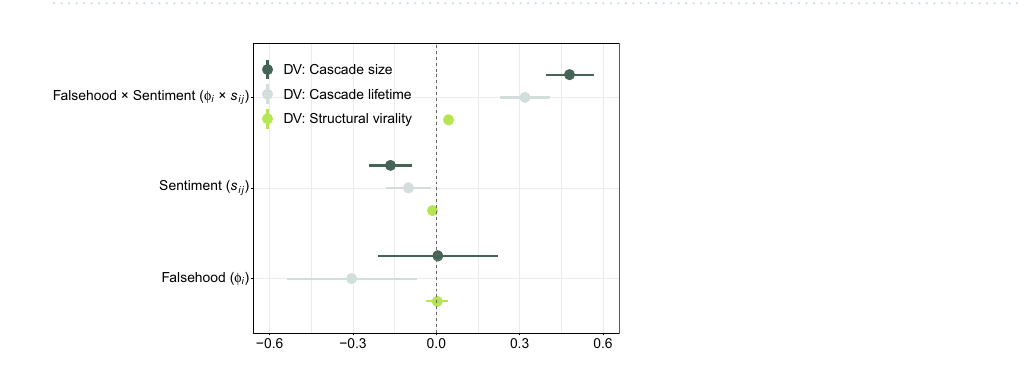
Figure 5. Standardized parameter estimates and 95% confidence